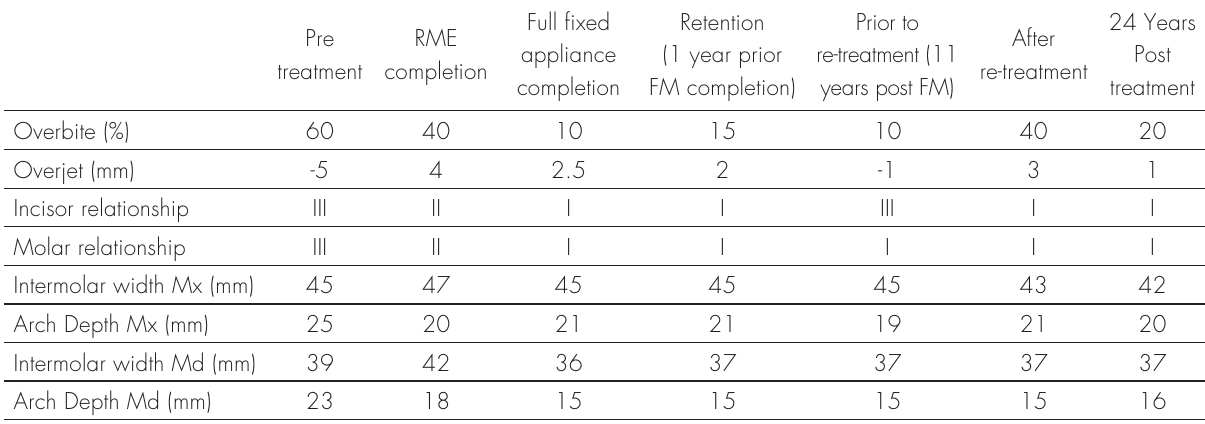
Table I. Clinical